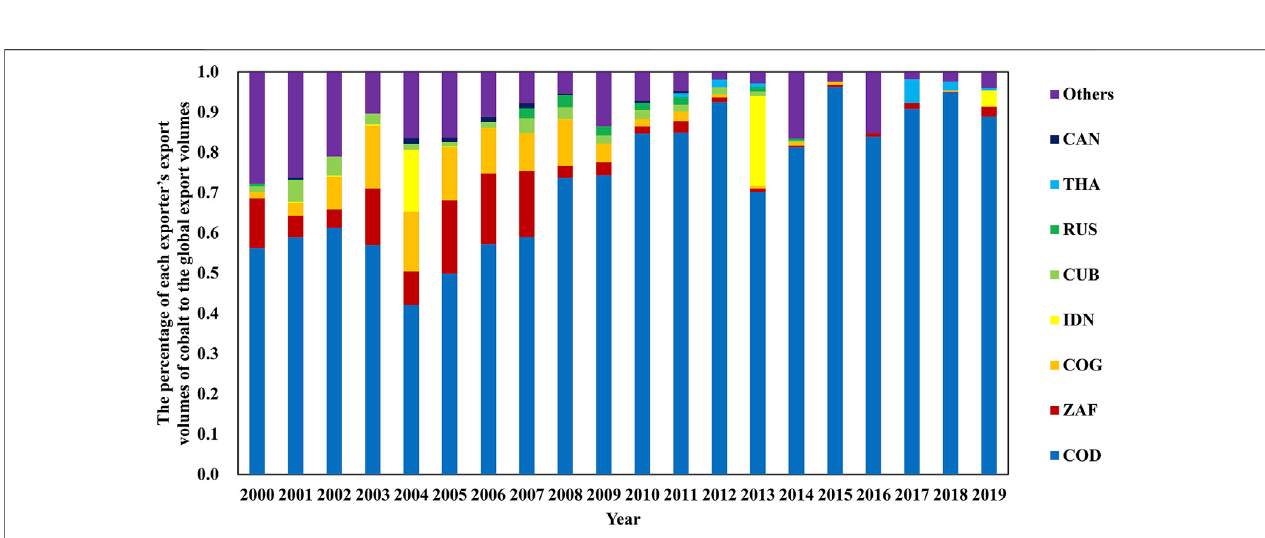
FIGURE 7 | The percentage of each exporter ’ s export volumes of cobalt to global export volumes in CEDN from 2000 to 2019.